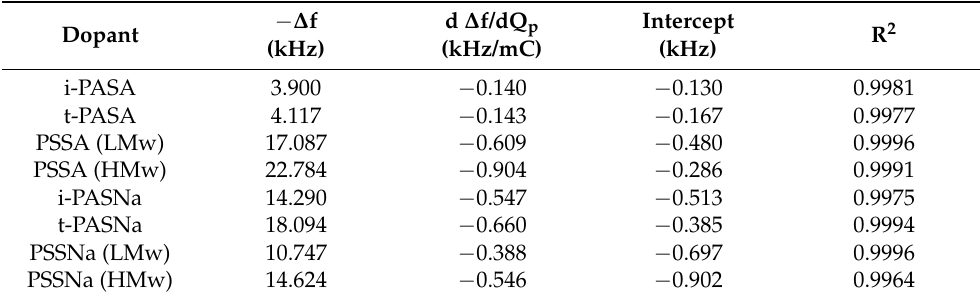
Table 1. Final values of the frequency shift and parameters of the linear fit of the ( − ∆ f) vs. Q p dependences shown in Figures 1 and 2 (plots